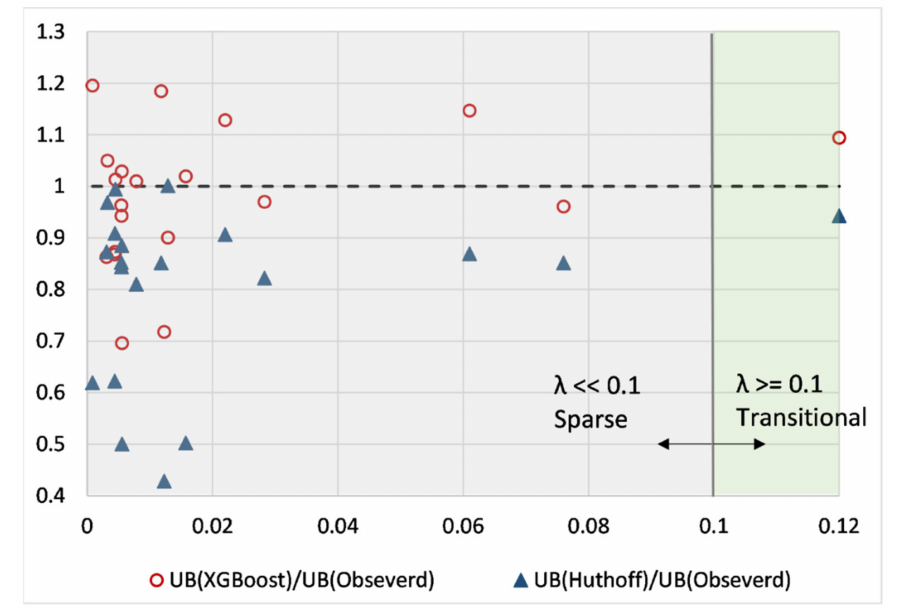
Figure 9. Comparison of XGBoost and Huthoff’s model in different flow regimes.